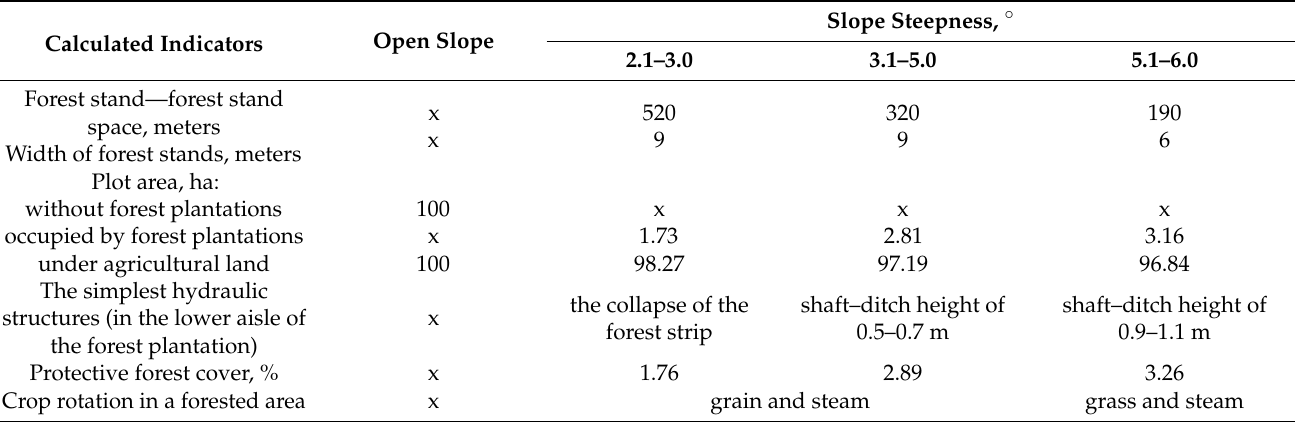
Table 1. Bioengineering and technological models of reclaimed forest land object on sloping lands in the dry steppe zone using Lanceolate ash (100